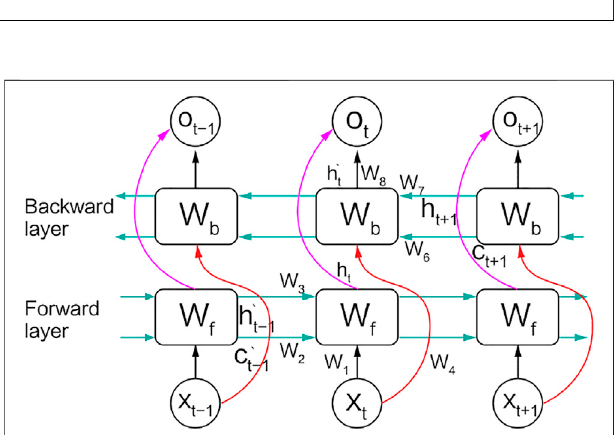
FIGURE 1 | Evolution model of the coal and gas outburst.